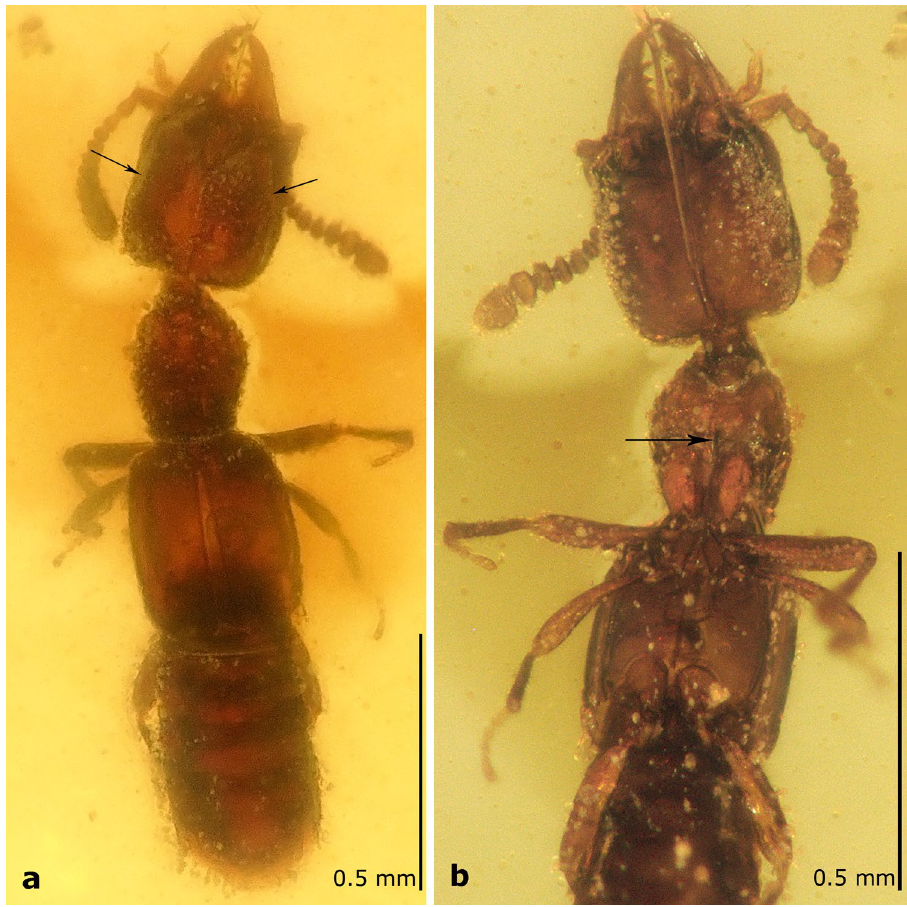
Figure 2. Midinudon juvenis gen. and sp. nov., holotype, collection number GPIH05515. (a) Photo of habitus, dorsal view. Ridges separating the flat area above and behind the eyes are marked with arrows. (b) Photo of head and thorax, ventral view. Longitudinal ridge of basisternum marked with an